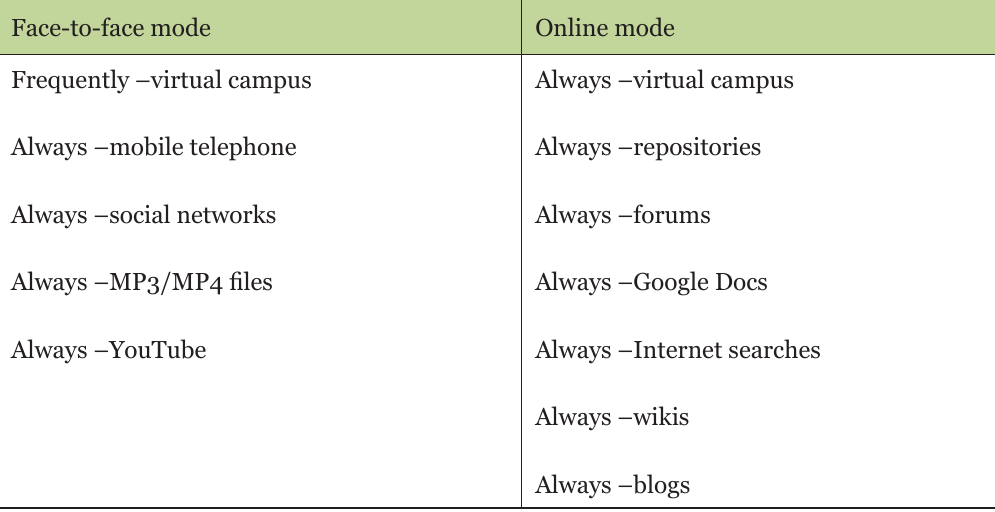
Formal Use of ICT at Teachers’ Suggestion Face-to-face mode Online